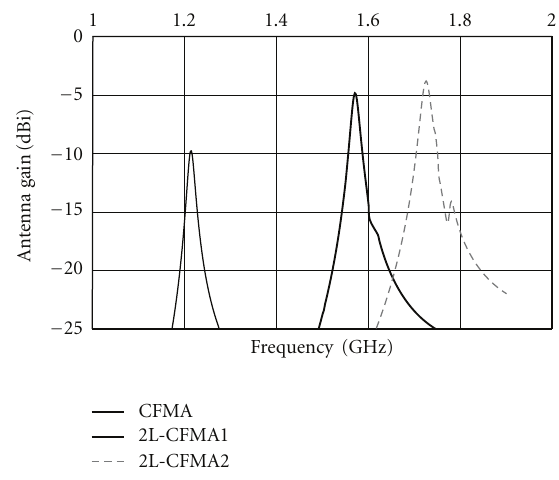
Figure 6: Simulated antenna gain characteristics.